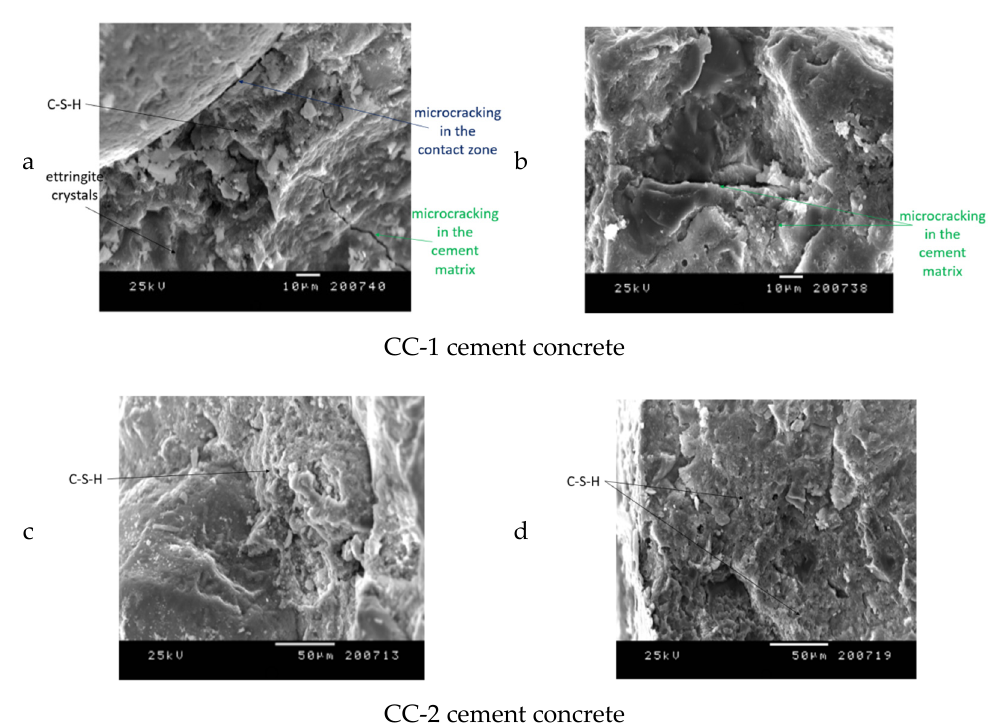
Figure 21. Construction of the internal structure of concrete subjected to thermal cycles according to scheme A for CC-1 and CC-2 concrete: ( a , c ) contact zone between the cement matrix and the aggregate grain, ( b , d ) cement matrix.